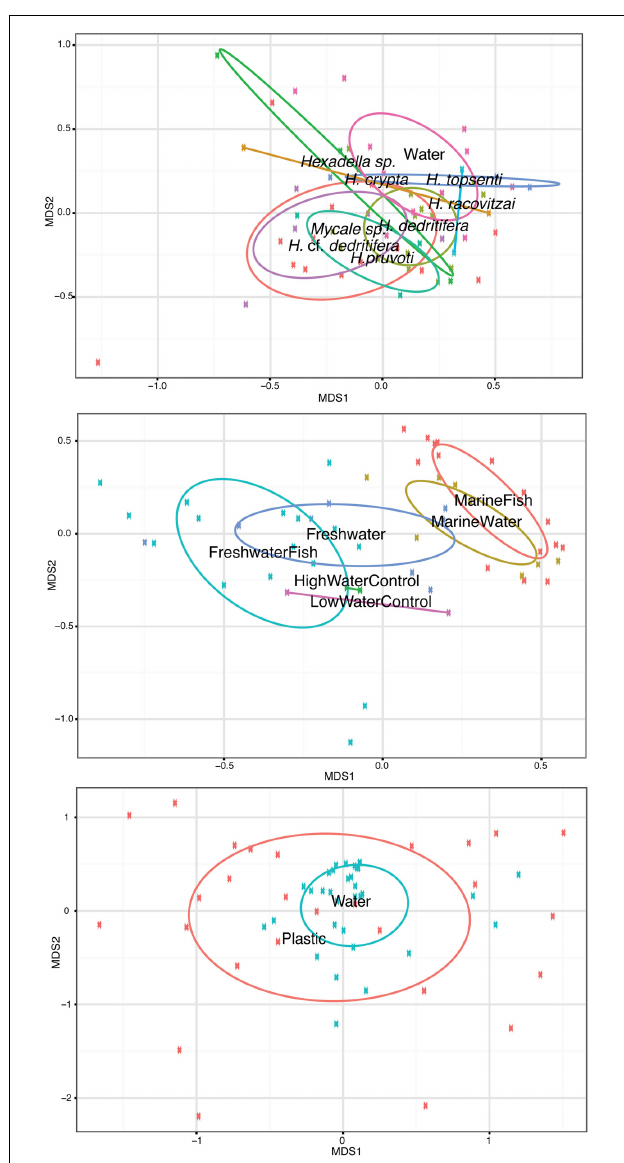
FIGURE 2 | Samples from the three host-associated studies included in this meta-analysis separated out into individual NMDS plots alongside water samples collected as part of the same study. Top: Sponges are labeled according to species. Water was collected next to Mycale sp. and Hexadella cf. dedritifera samples only. Middle: Fish water was sampled directly from aquaria in which fish were housed, in addition to “control” water that was sampled from aquaria at an identical salinity, but without any fish. Bottom: Ocean surface water was collected at the same time and location as corresponding plastics. ANOSIM permutation tests show that Fish, Sponge and Plastic associated Vibrio communities cannot be statistically separated out from their surrounding water environment. Labels for each habitat are within their respective covariance